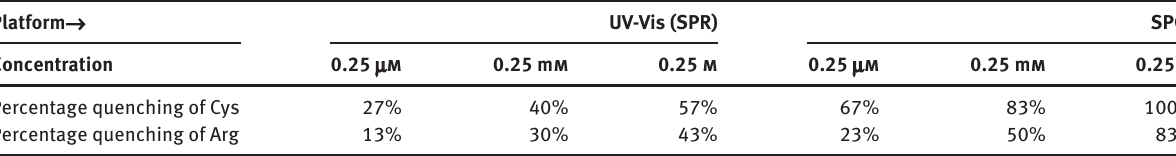
Table 2: Variation of percentage quenching for Cys and Arg (SPR versus SPCE platform). Platform → UV-Vis (SPR)